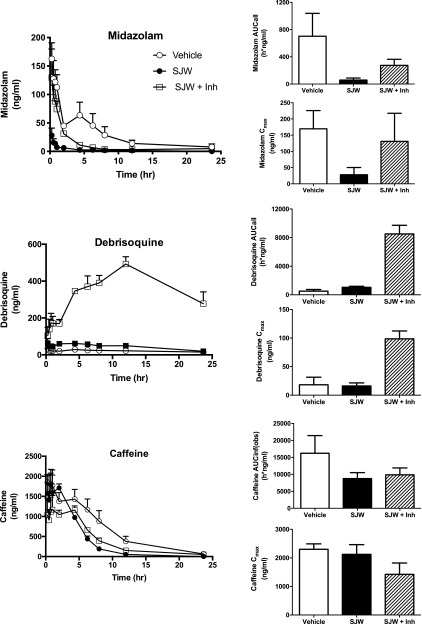
Pharmacokinetics of probe drugs in 8HUM mice treated with St. John’s Wort with and without P450 inhibitors. Female 8HUM mice were treated with vehicle (open circles, n = 5), St. John’s Wort (closed circles, n = 3), and SJW and ketoconazole and quinidine (open squares, SJW + inhibitor, n = 3) before being dosed with a drug cassette and a PK profile carried out as detailed in Materials and Methods for caffeine, debrisoquine, and midazolam. Data shown are mean ± S.D.